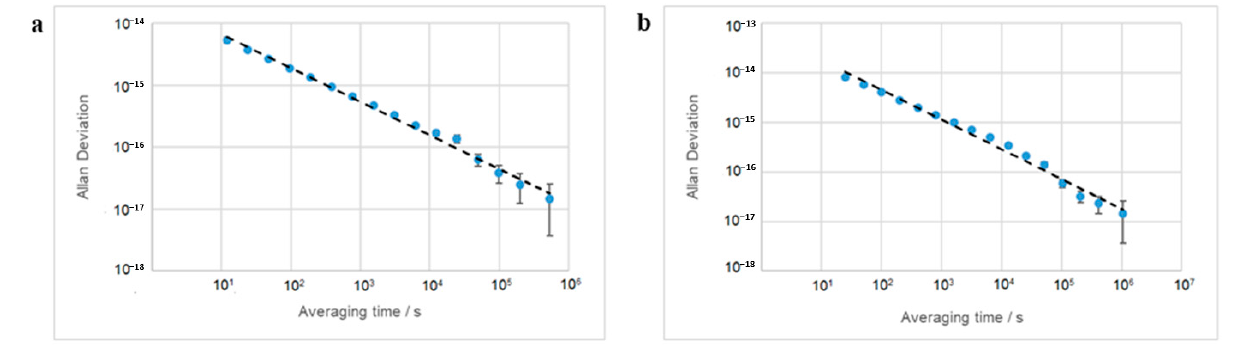
Table 1. Results of the height difference by frequency comparison.